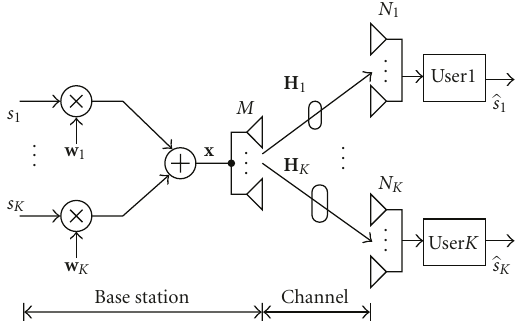
Figure 1: Multiuser MIMO downlink